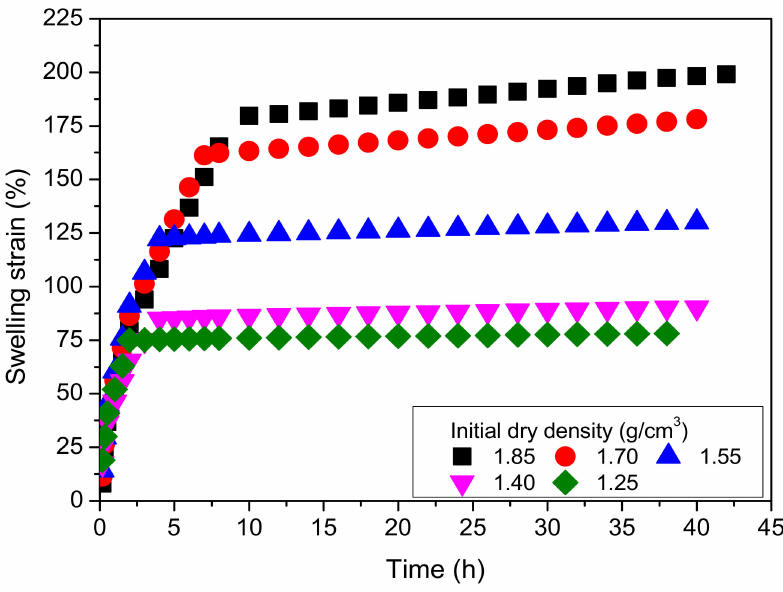
Figure 6. Relationships between unloaded swelling strain and swelling time for MB specimens with different initial dry densities under saline water conditions.